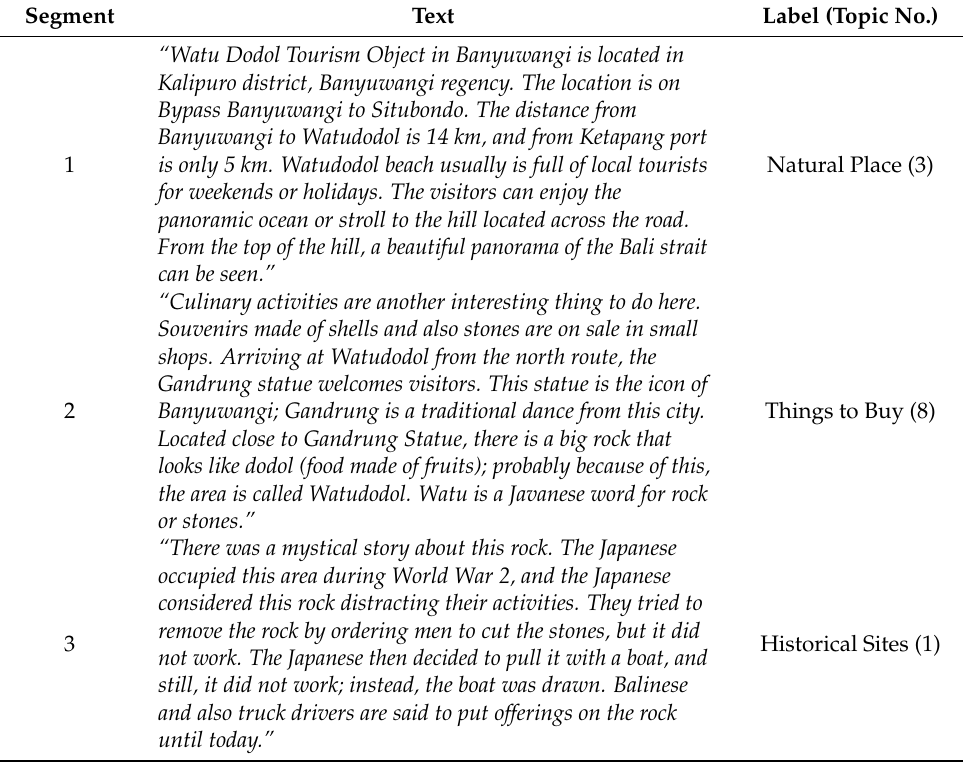
Table 5. The review example segmented and